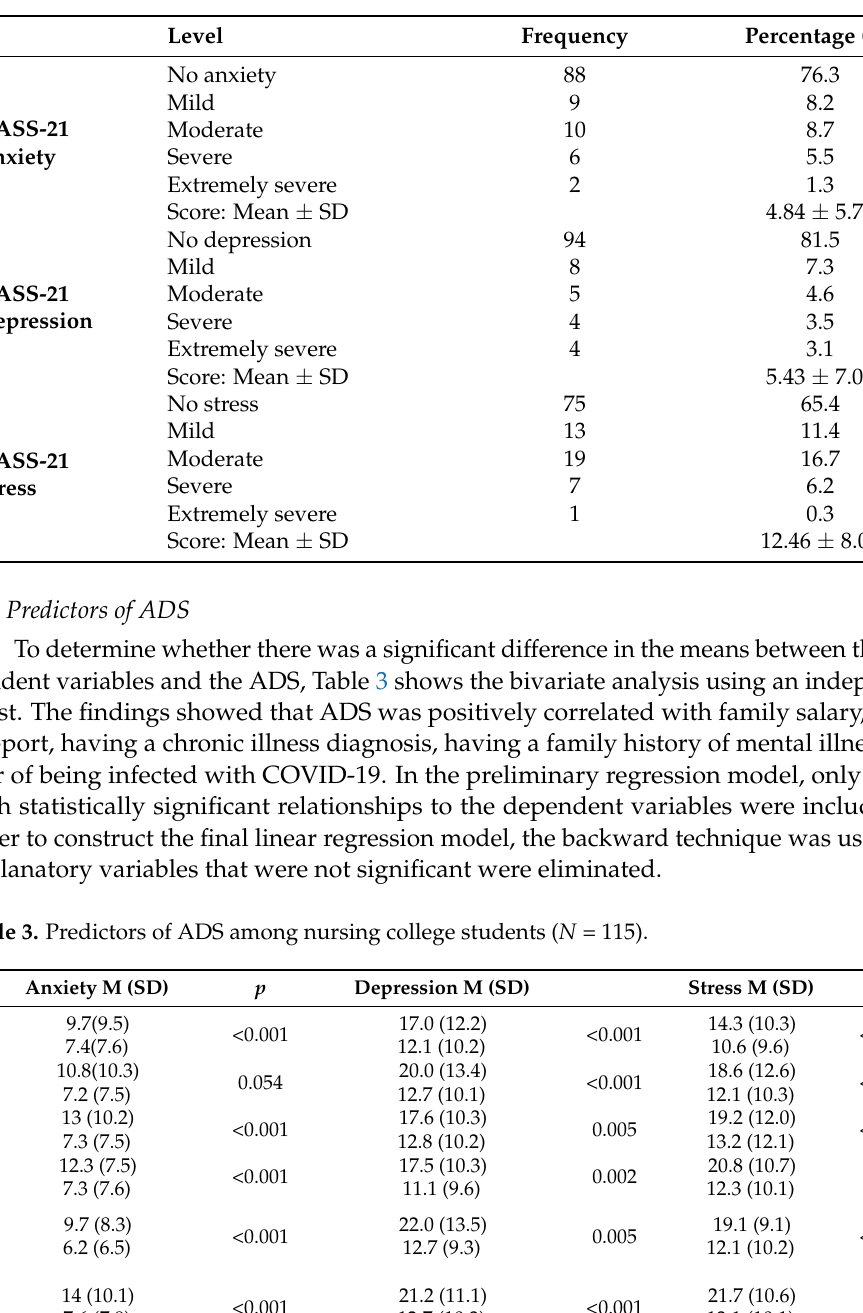
Table 2. Prevalence of ADS ( N = 115).